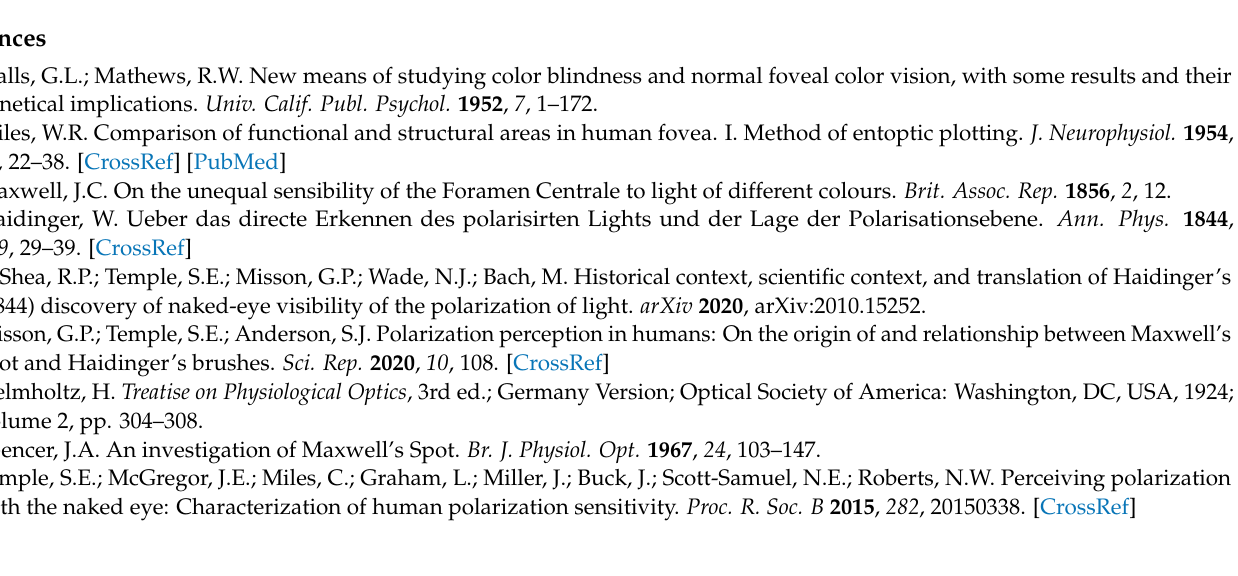
Table S3: Multiple regression (stepwise forward